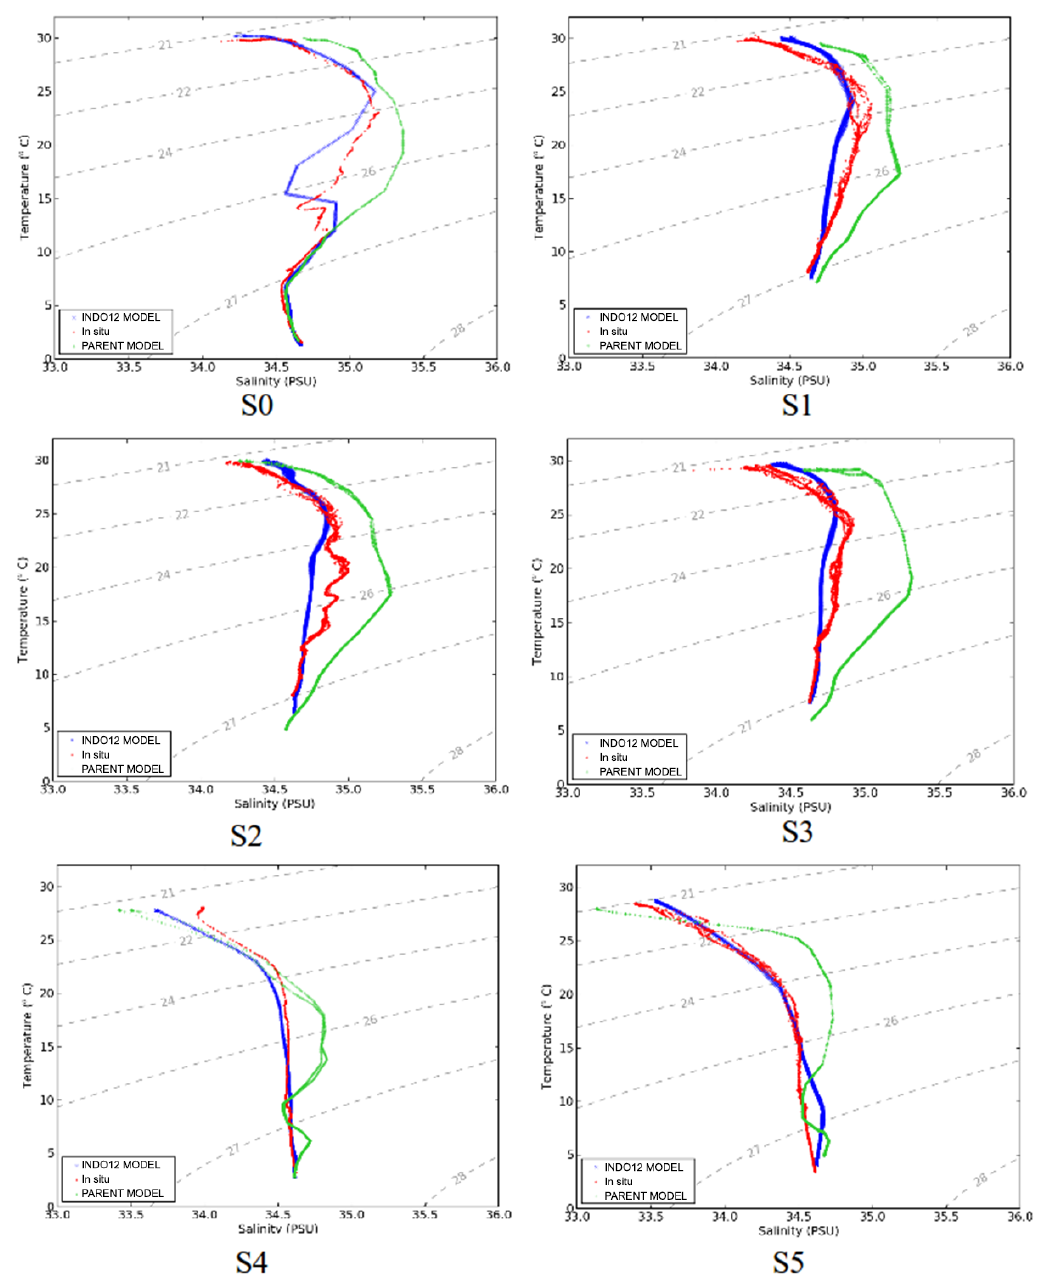
Figure 20. Collocated T – S diagrams to INDOMIX data (red) from hourly fields of INDO12 simulation (dark blue) and from daily mean fields of parent model PSY3 (green) in July 2010 at all mooring locations. Salinity (PSU) and temperature ( ◦ C) are plotted along x and y axes,